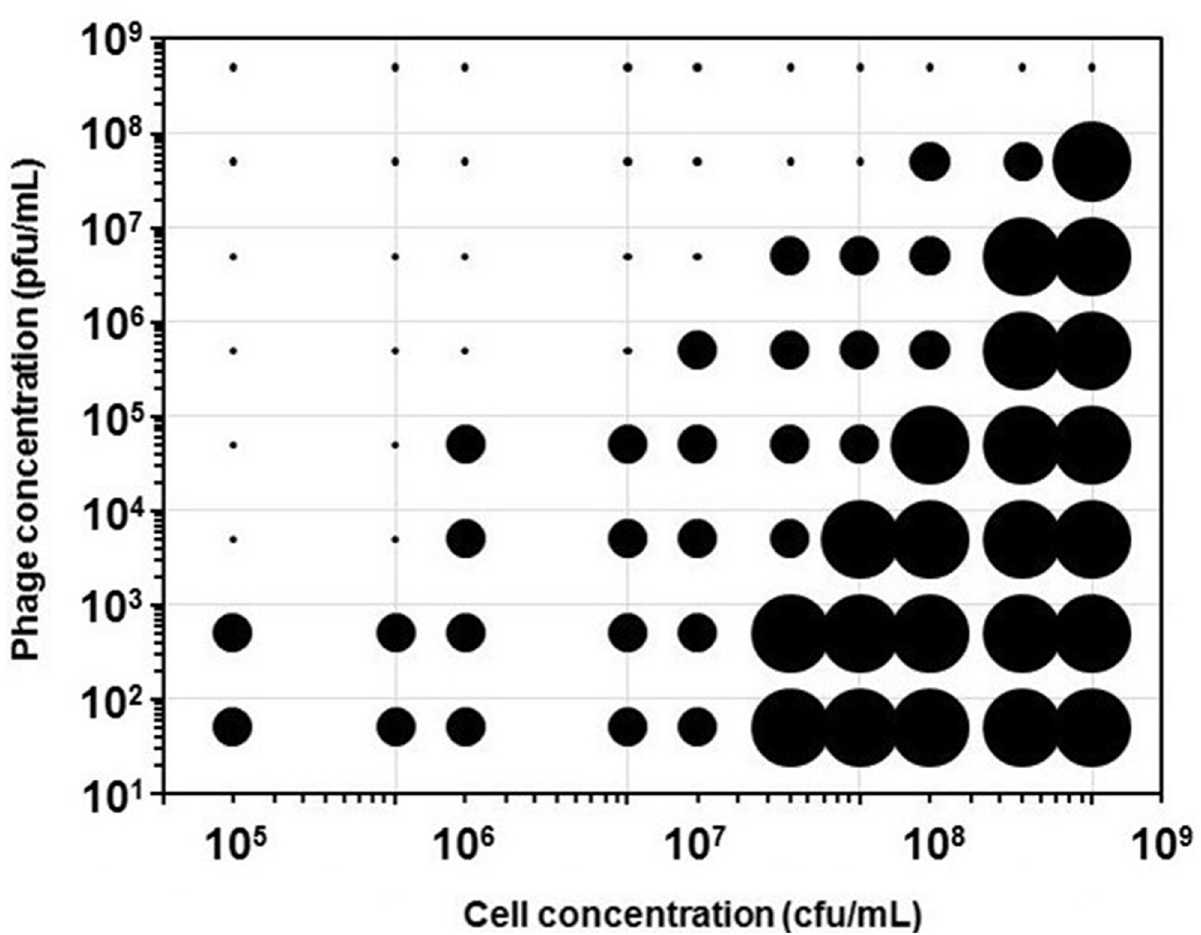
Fig 4. Lysis behavior of the different combinations of T4 and E . coli concentrations assayed. Large circles indicate the absence of lysis; small dots indicate complete lysis right from the beginning of the experiment. Intermediate circles indicate the existence of delayed lysis, this is, significant bacterial growth can be observed before the onset of